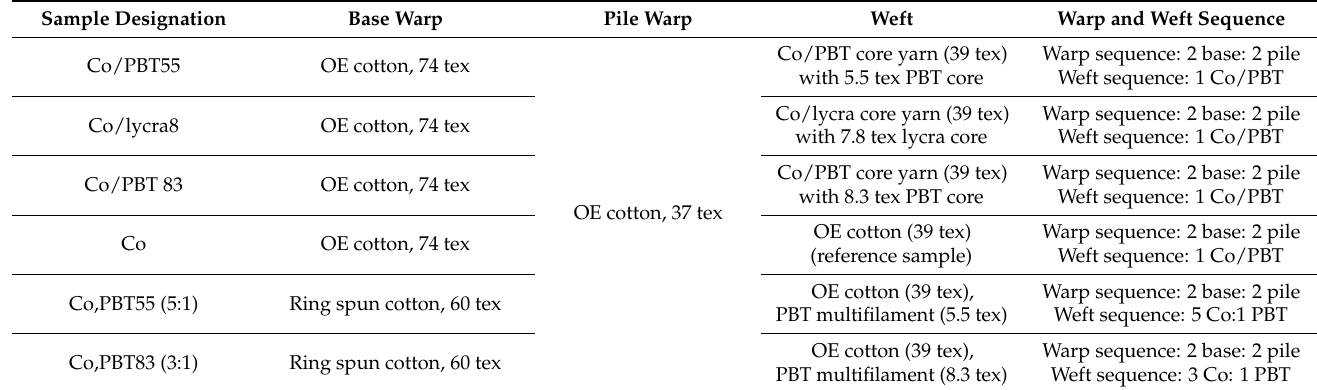
Table 3. Properties of terry samples before (b.t.) and after (a.t.) treatment.